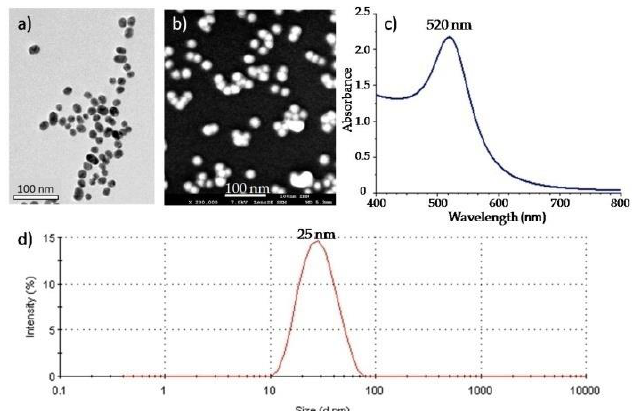
Figure 1. Example of characterizations carried out on Au Np colloidal suspensions synthesized during this work: ( a ) TEM images (scale bar of 100 nm) of one deposited drop on carbon sheet, ( b ) scan electronic image of deposited drops from a spray on SEM substrates ( c ) UV-vis spectrum recorded for this colloidal solution and ( d ) DLS characterization.